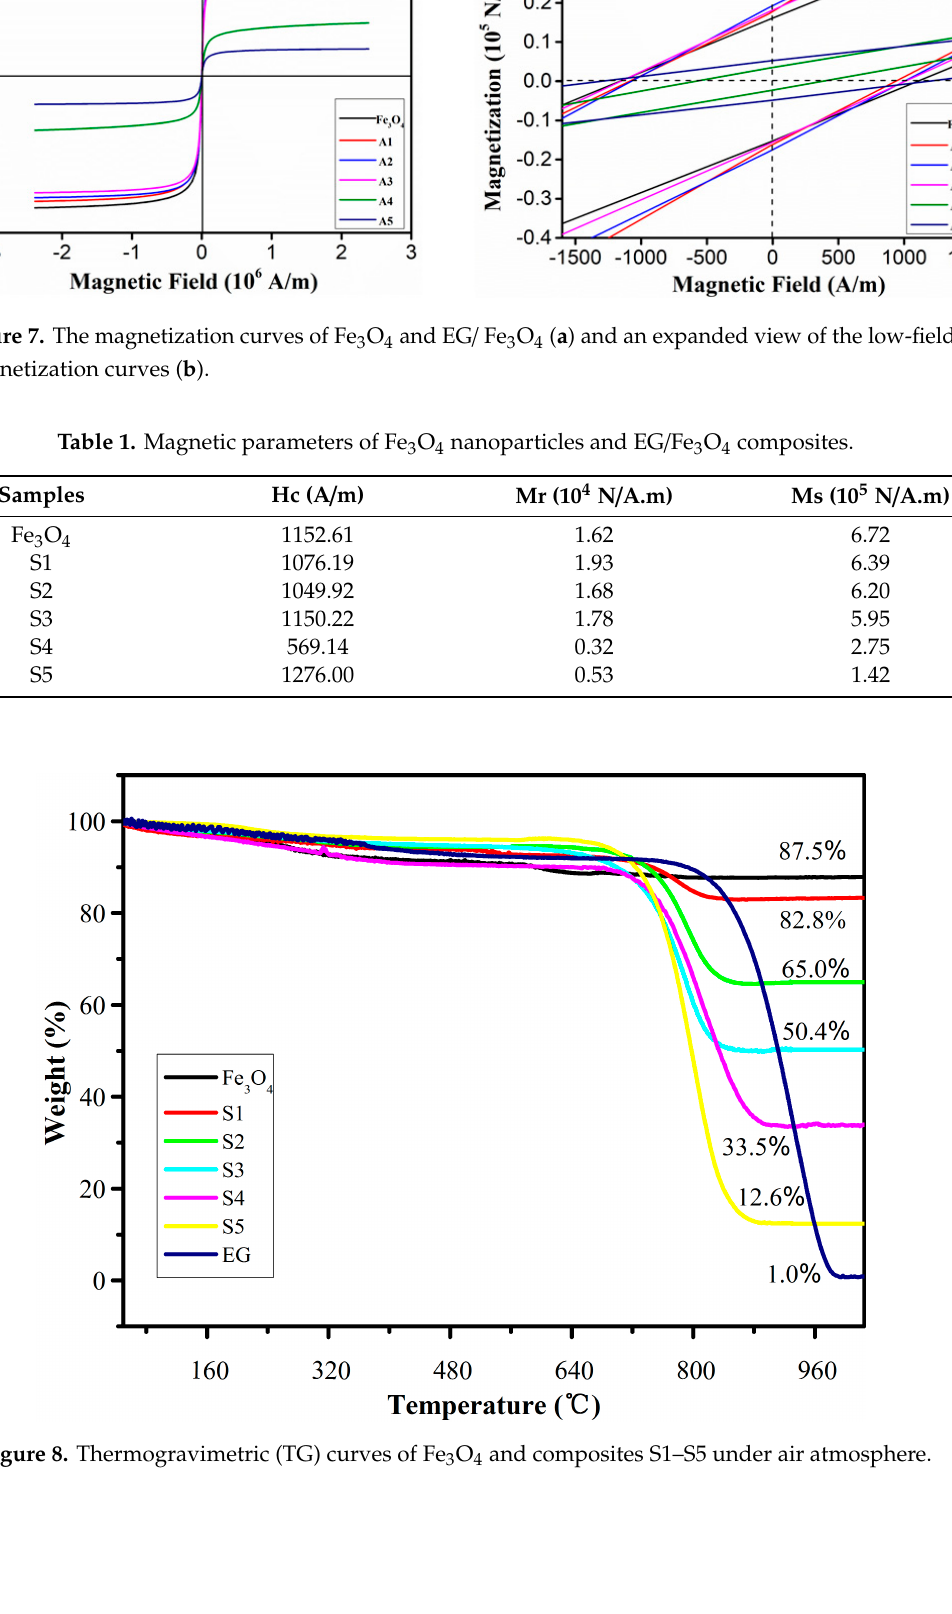
Figure 8. Thermogravimetric (TG) curves of Fe 3 O 4 and composites S1–S5 under air atmosphere.